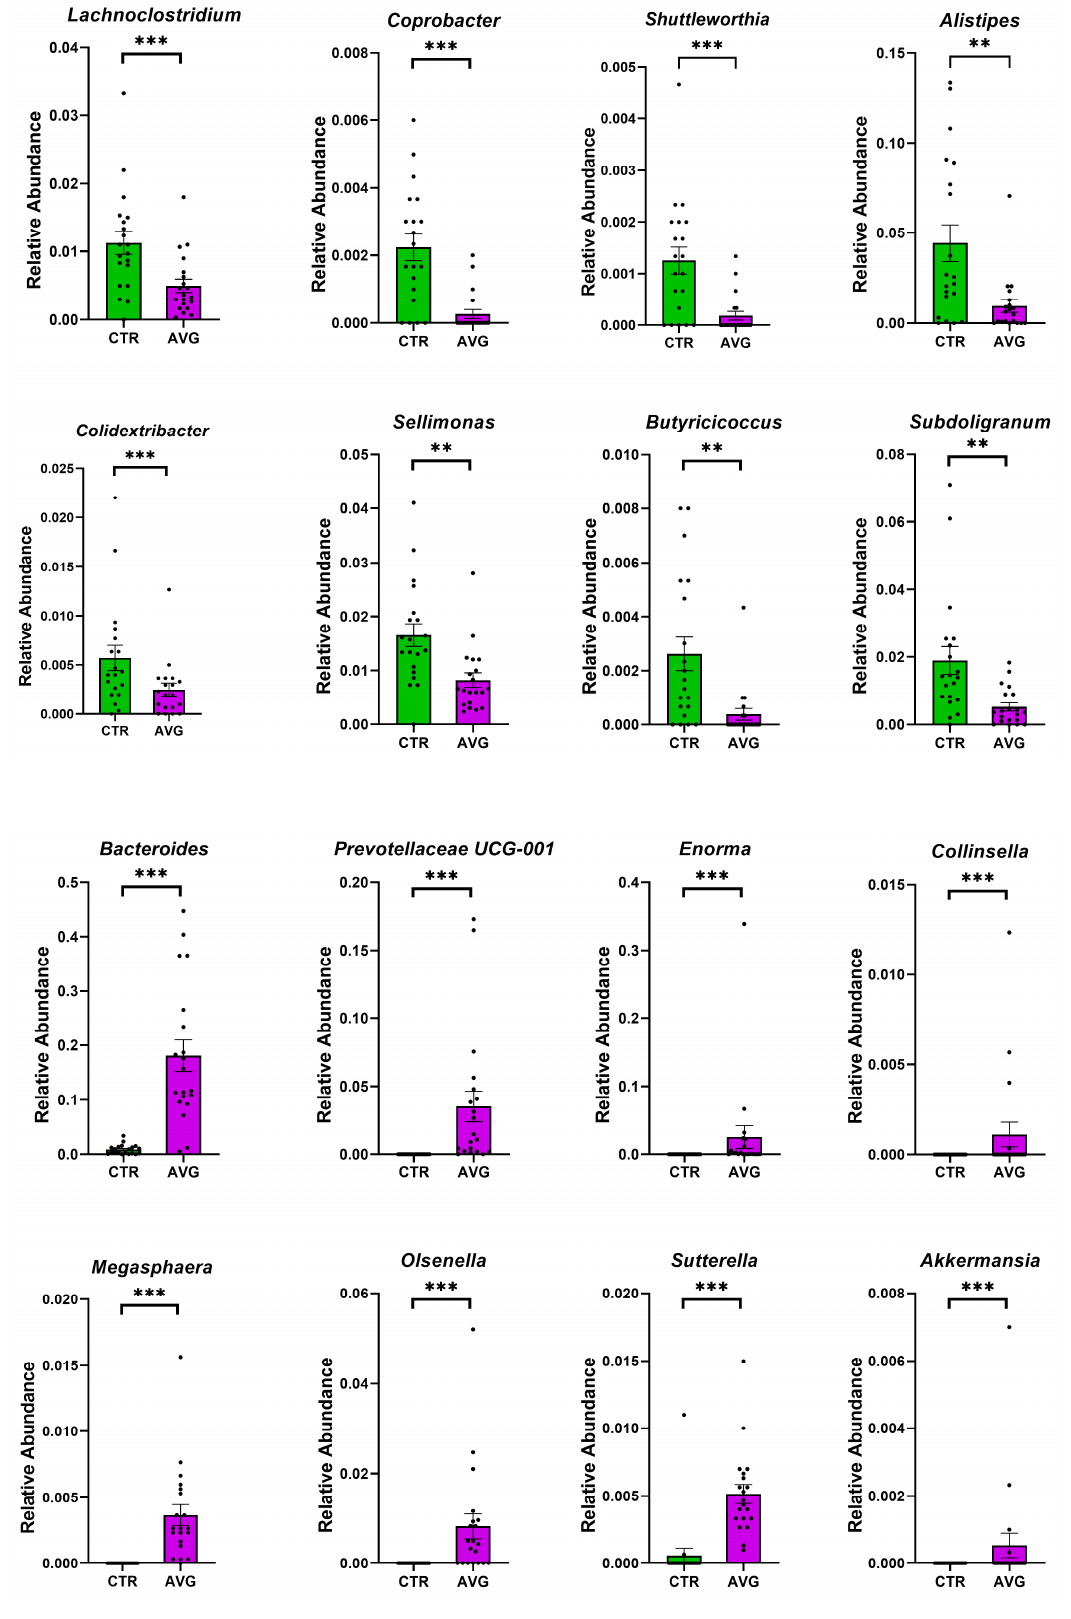
Figure 6. Metastats selected differentially ( p < 0.001) abundant genera in the caecum. The asterisk indicates significance level (*** p < 0.001; ** p < 0.01). Each dot represents one sequenced sample relative abundance.